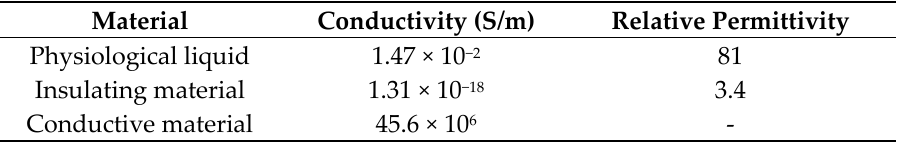
Table 1. Parameters used for the